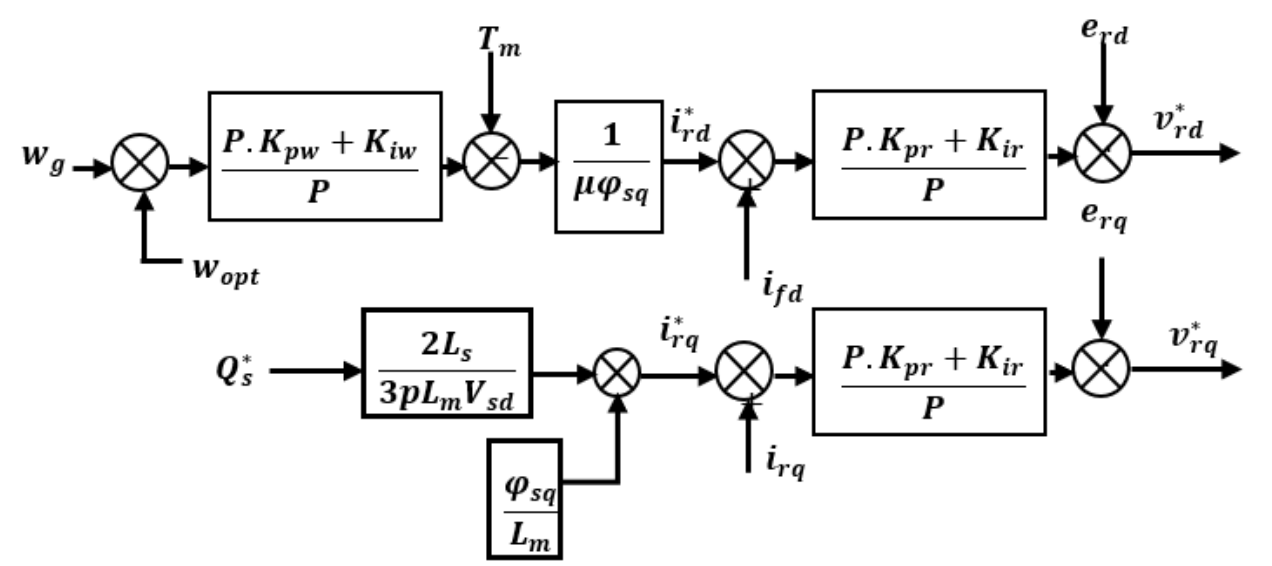
Figure 5. RSPC PI controller setup showing generator speed and stator reactive power control.